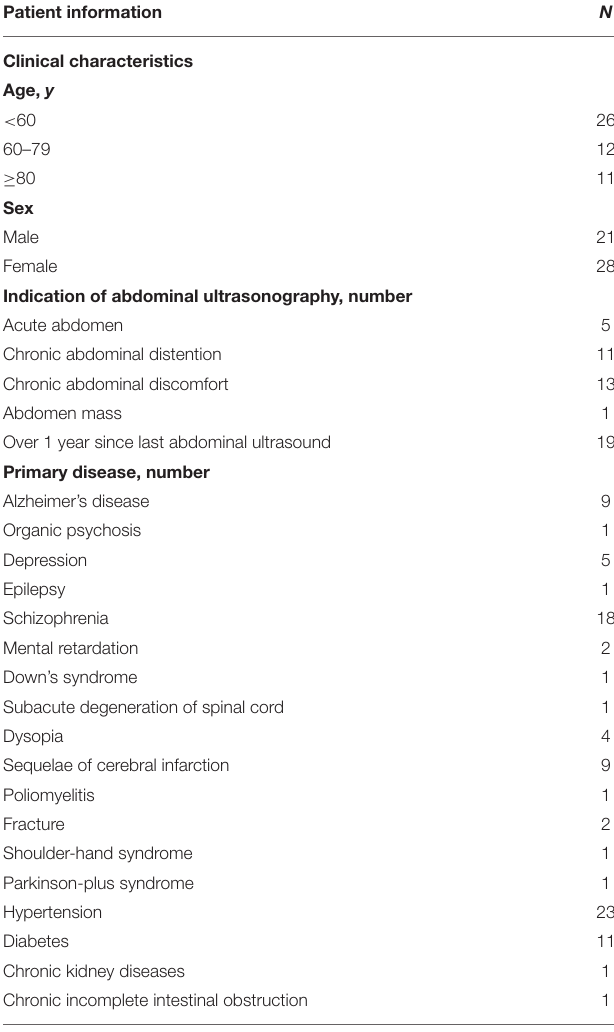
TABLE 2 | Comparison of the results of the 5G robot-assisted remote and bedside ultrasound examinations. Bedside